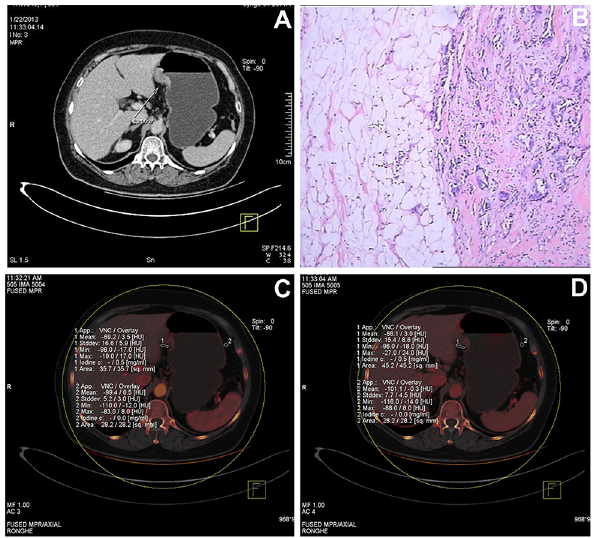
Fig 1. Representative CT images obtained from a 68 year-old female patient. (A) The mixed venous phase image shows thickening of the wall of the lesser curvature with transmural enhancement (arrow). Based on the mixed image, the tumor was classified as stage cT3. (B) The histological image, stained with hematoxylin and eosin (HE, ×100), revealed a grade II adenocarcinoma with invasion of surrounding soft tissue. The pathologic stage was pT4a. (C) The iodine map image at the arterial phase shows that the iodine concentration was 0.5 mg/mL in the fat near the tumor (ROI 1), but 0 mg/mL in the fat in a normal region distant from the tumor (ROI 2). (D) The iodine map image at the venous phase shows that the iodine concentration was 0.5 mg/mL in the fat near the tumor (ROI 1), but 0 mg/mL in the fat in a normal region distant from the tumor (ROI 2). This indicates that the serosa was invaded by the